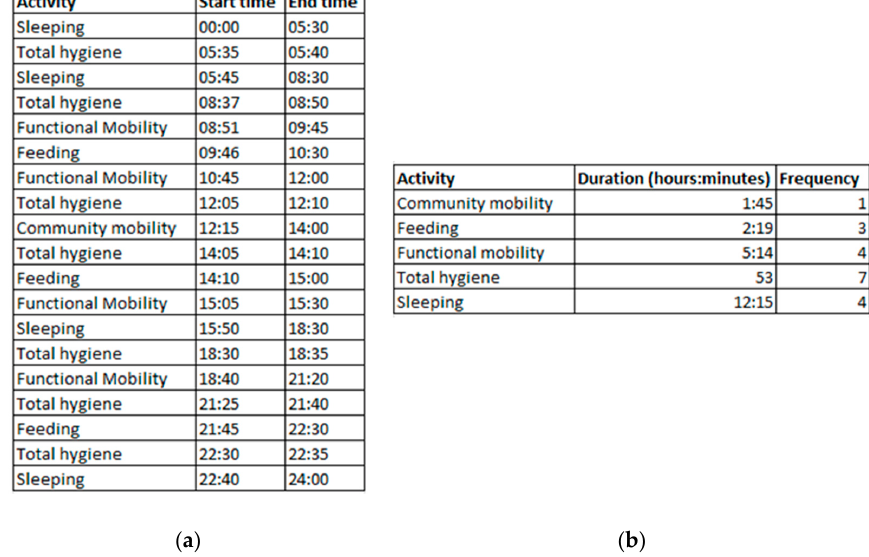
Figure 2. ( a ) Example of monitored older adult activities in a day; ( b ) features extracted and used in machine learning.